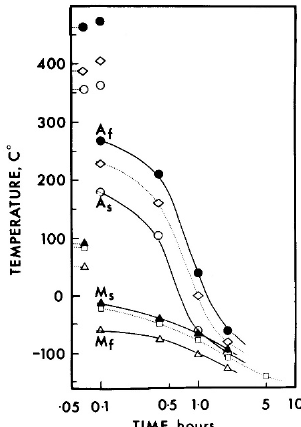
Figure 5. Transformation temperatures determined by DSC for Fe-24.5 at. %Pt alloy as a function of ordering time at 650 °C. The dotted lines show DSC peak temperatures and data points near the ordinate are for disordered alloy. Note that two reversion ranges are present after ordering for 0.1 h. [49].